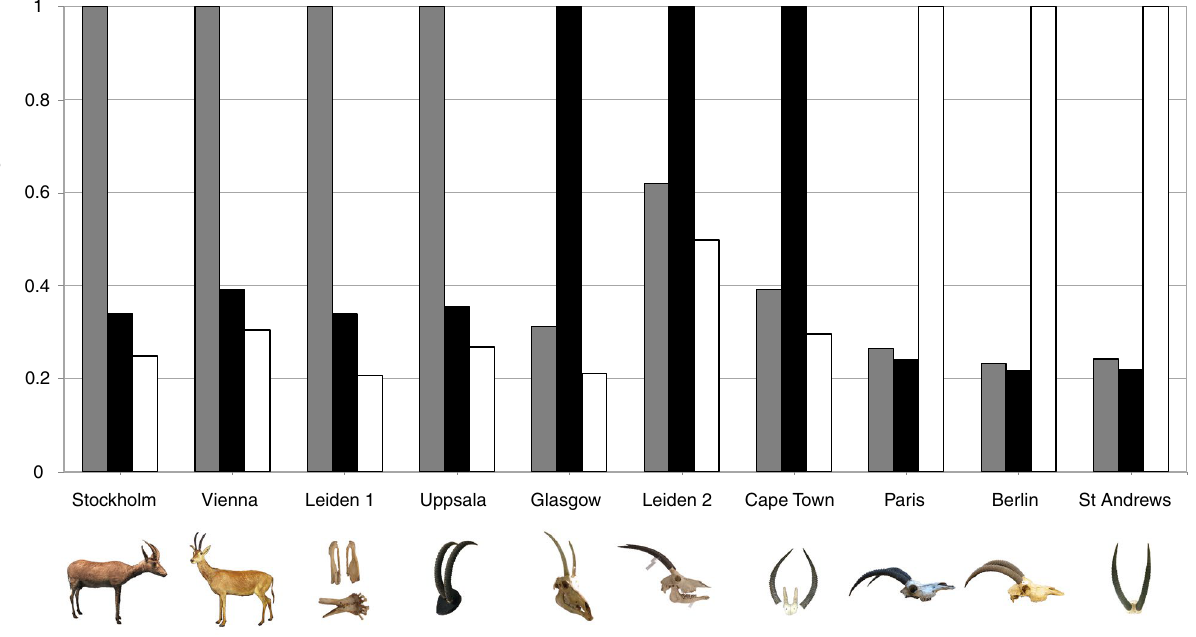
Figure 2. Mapping success to the three Hippotragus references. Comparison of normalized relative mapping success for each sample as base pairs mapping to the mitochondrial genomes of the three Hippotragus species. For each sample the result of the reference it mapped best to was defined as a mapping success of 1 and the results for the other references are given in relation to that. Only four specimens can unambiguously be assigned to the blue antelope (grey), while three are identified as sable (black) and three as roan (white). Photo credits: Glasgow: Photo: E. Hempel, courtesy: the Hunterian, University of Glasgow; Berlin: Photo: E.